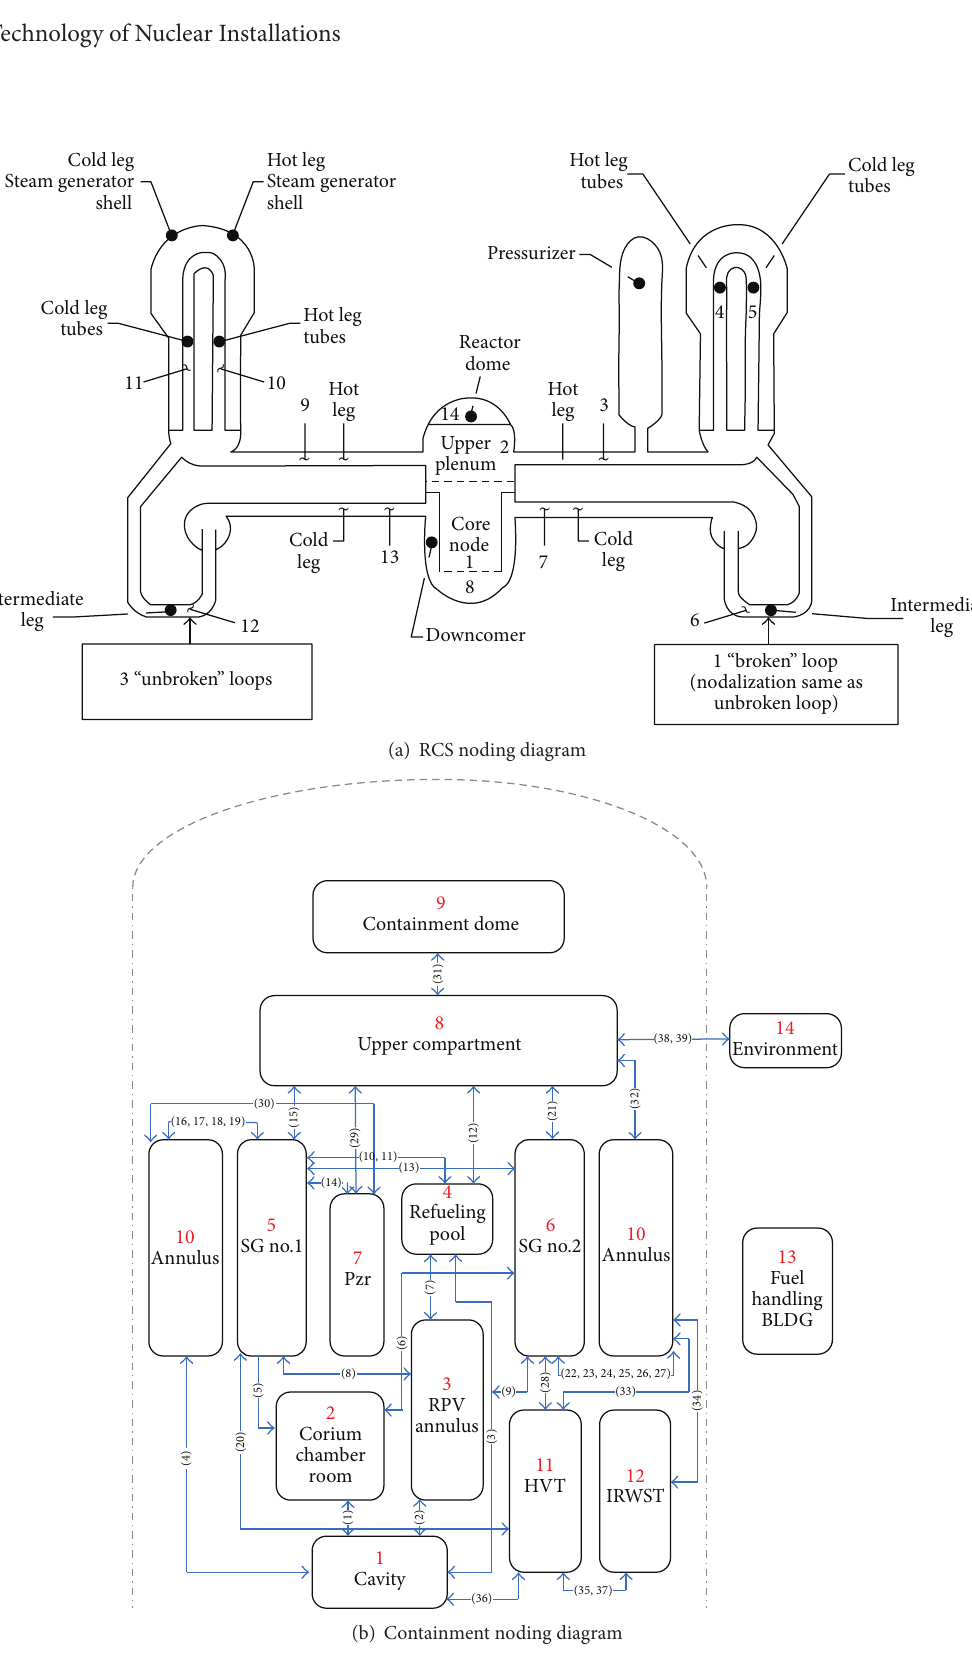
Figure 3: MAAP noding